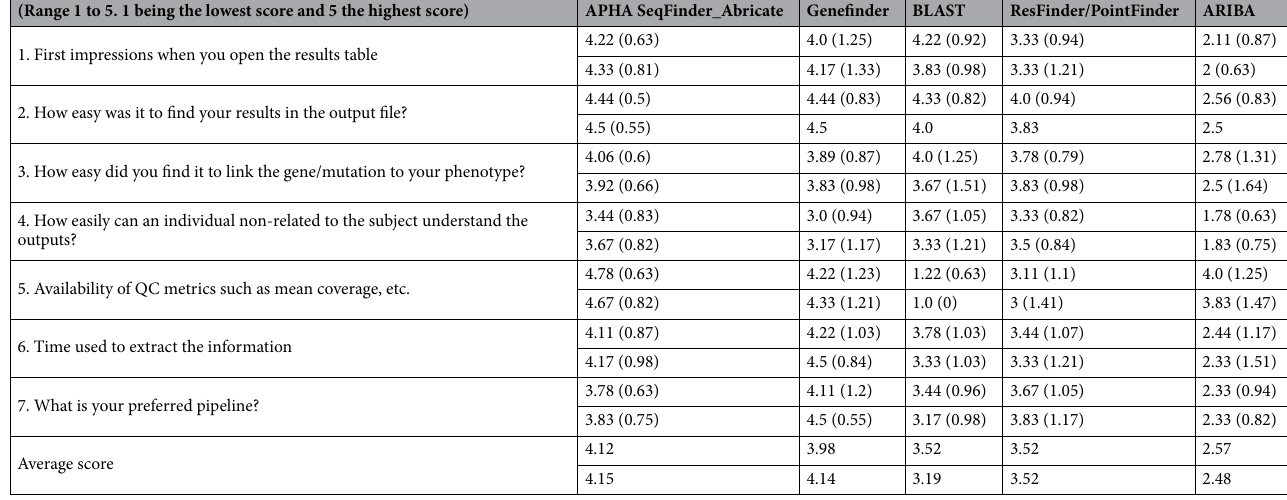
Table 4. Questionnaire, average scores and standard deviation (between brackets) for responses from the 9 collaborators for each of the pipelines evaluated (top line), and responses from the six institutes independent from any software used in this study (bottom line). Scores range from 1, being the lowest (worst) score to 5 being the highest (most positive)